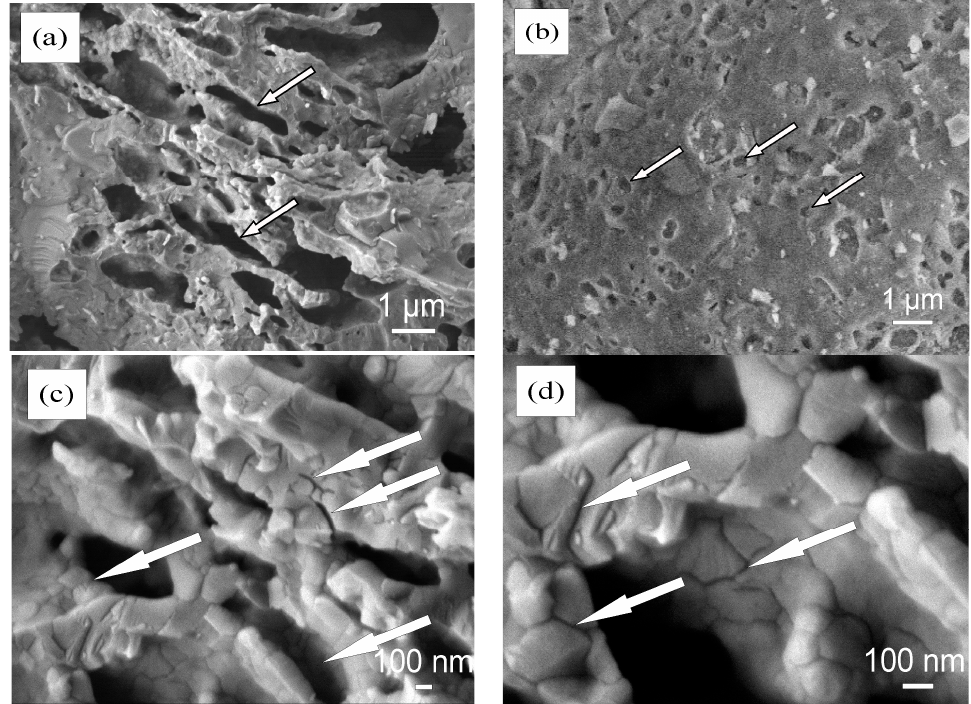
Figure 8. View of the microstructure of ceramic bodies CS and CD20 fired at 1060 °C: ( a , b ) magnification ×2000; ( c ) magnification ×40,000; ( d ) magnification ×75,000.